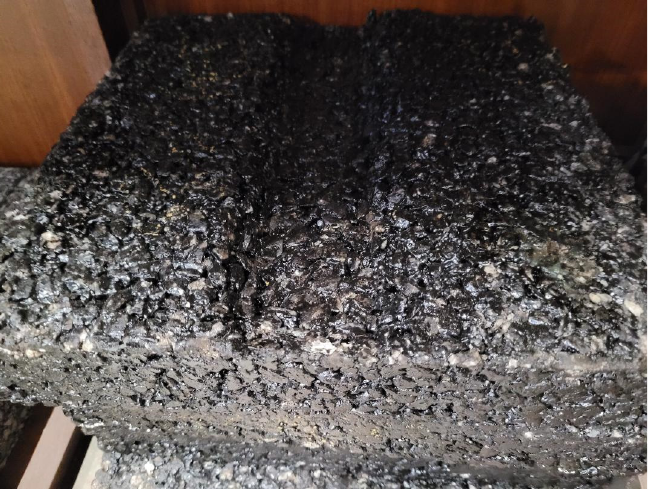
Figure 8. Photograph of a wheel track test sample made with the 1.5% GGBFS asphalt mixture.